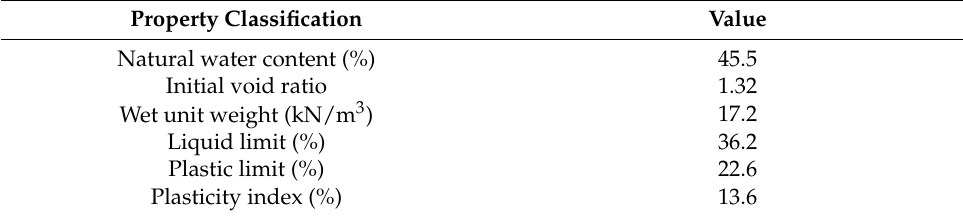
Figure 1. Main raw material of ( a ) waste silt, ( b ) CCR, and ( c ) PA. Table 1. Physical properties of the waste silt. Property Classification